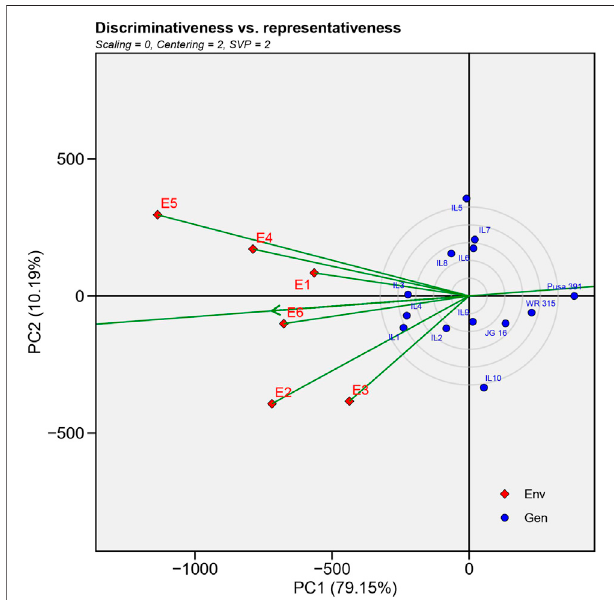
FIGURE 4 | GGE-biplot environment view for yield that shows the correlation between test environments and correlation coef fi cient between any two environments is approximated by the cosine angle between their